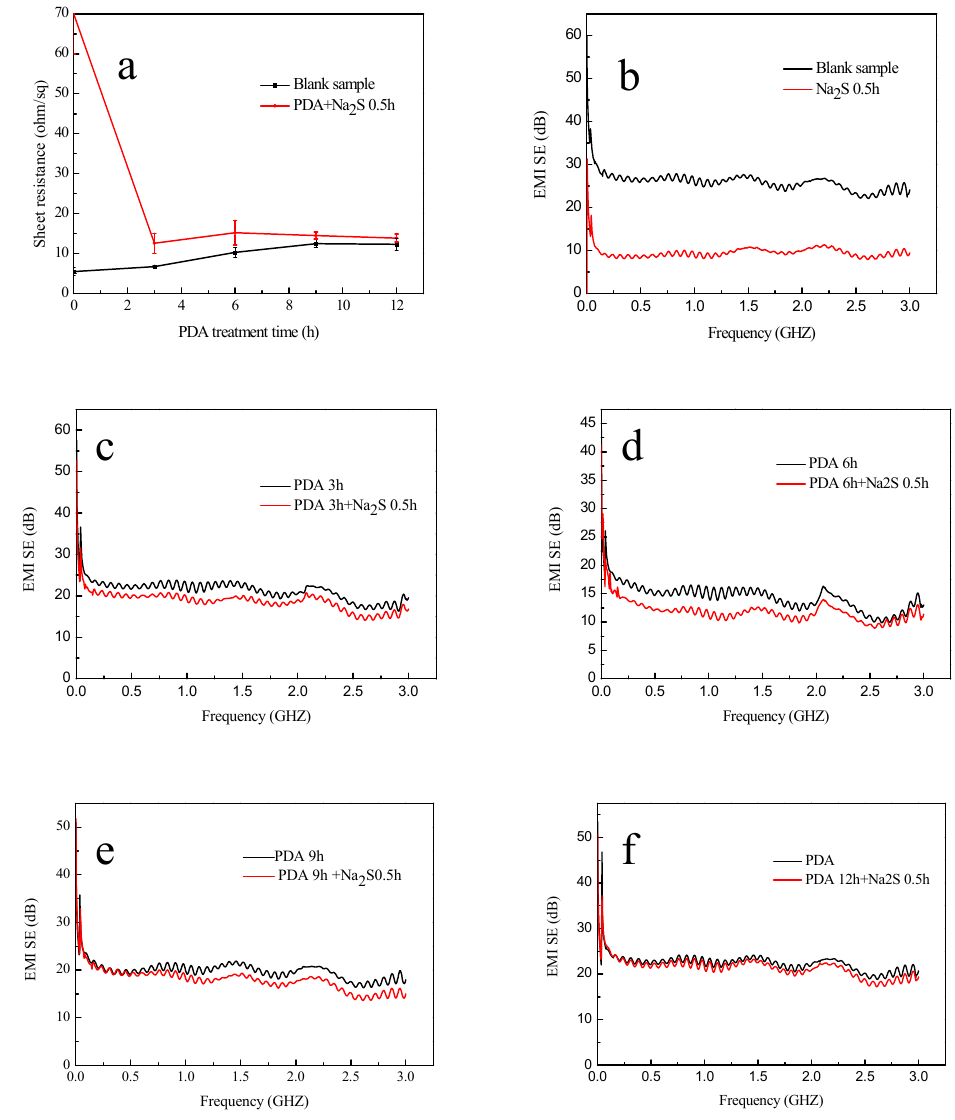
Figure 12. Electrical conductivity and EMI SE of the samples: ( a ) the sheet resistance of the treated samples before and after the treatment of Na 2 S; ( b – f ) EMI SE of the samples before and after the treatment of Na 2 S with di ff erent infiltration times of dopamine.